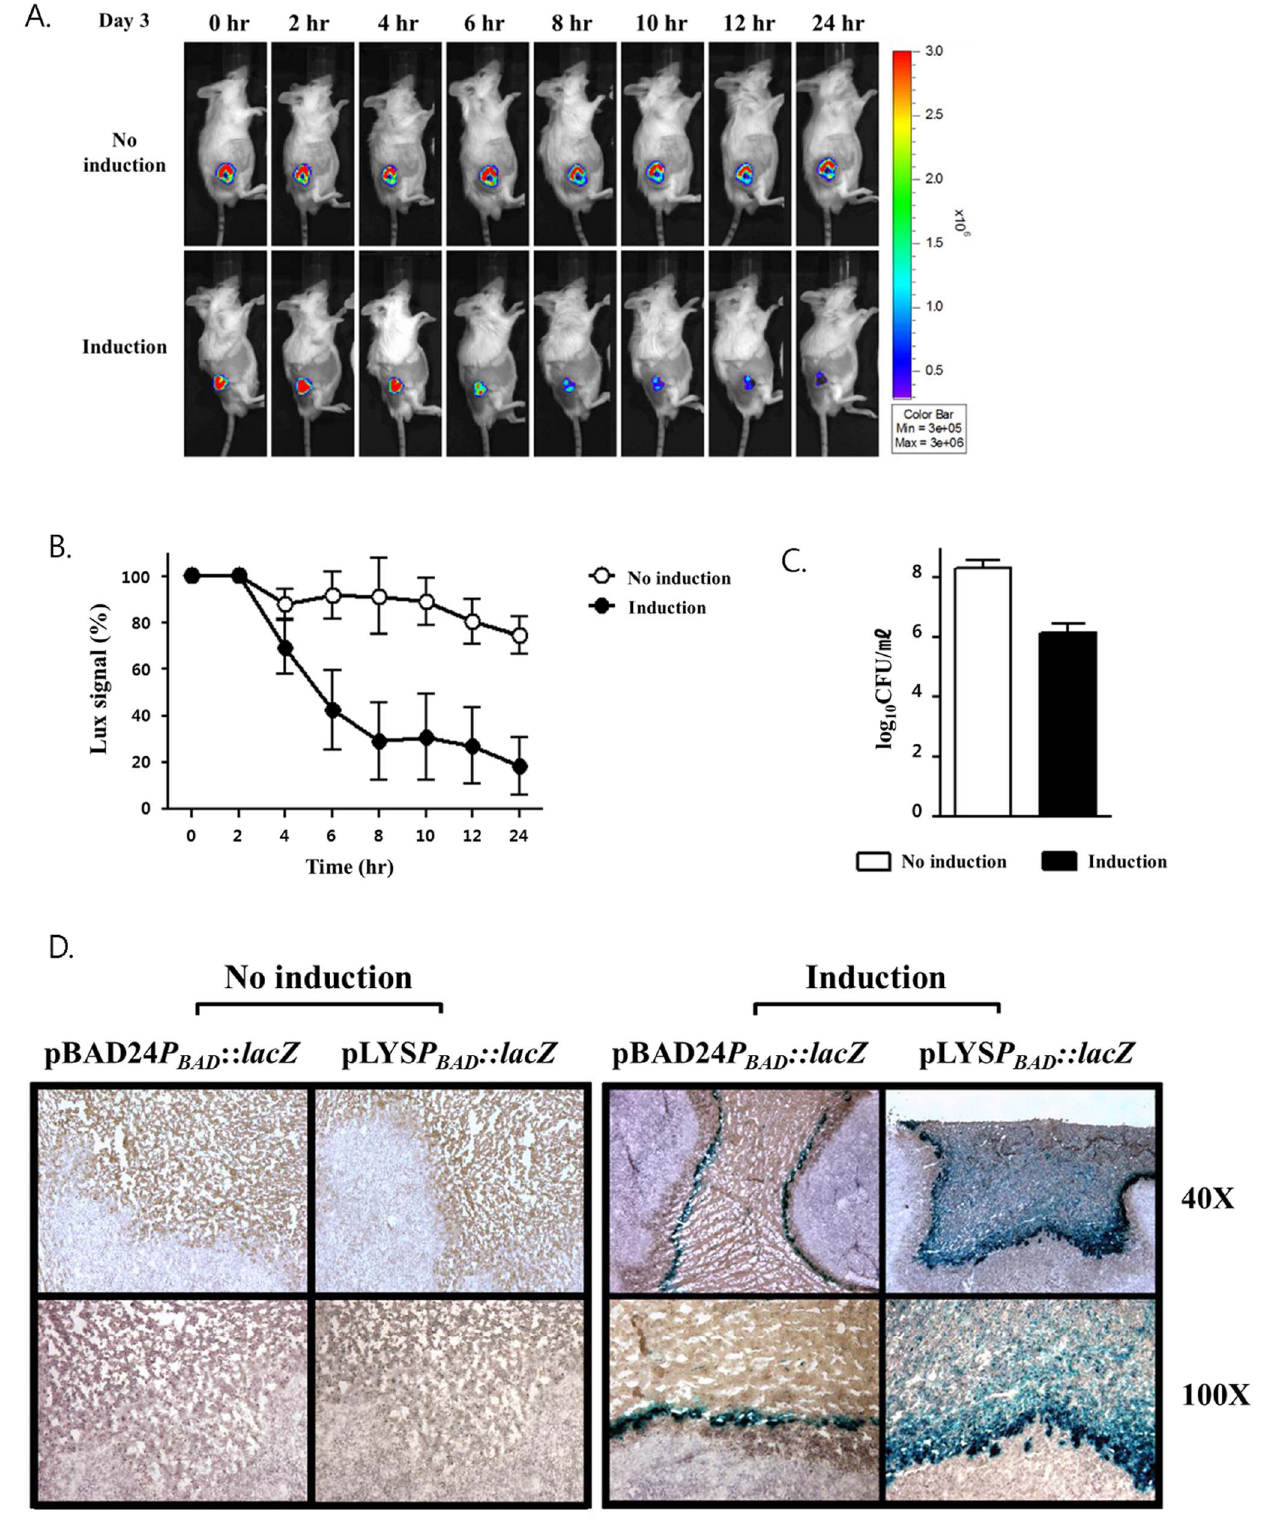
Figure 3. Monitoring of L-arabinose-induced bacterial lysis by a non-invasive invivo imaging system (IVIS) and release of b - galactosidase from Salmonellae carrying pLYS P BAD :: lacZ or pBAD24 P BAD ::lacZ targeted to implanted tumor tissue (CT26) in BalB/c mice. Each time point represents the mean for n=3 animals. (A) Bioluminescent bacteria (SKS003) carrying pLYS were injected intravenously into CT26 tumor-bearing mice. After three days, the bioluminescence signal from the Salmonellae was monitored by a non-invasive in vivo imaging system (IVIS) at the indicated times after intraperitoneal injection of L-arabinose (60 mg) in the induced group. The Y-axis indicates photons